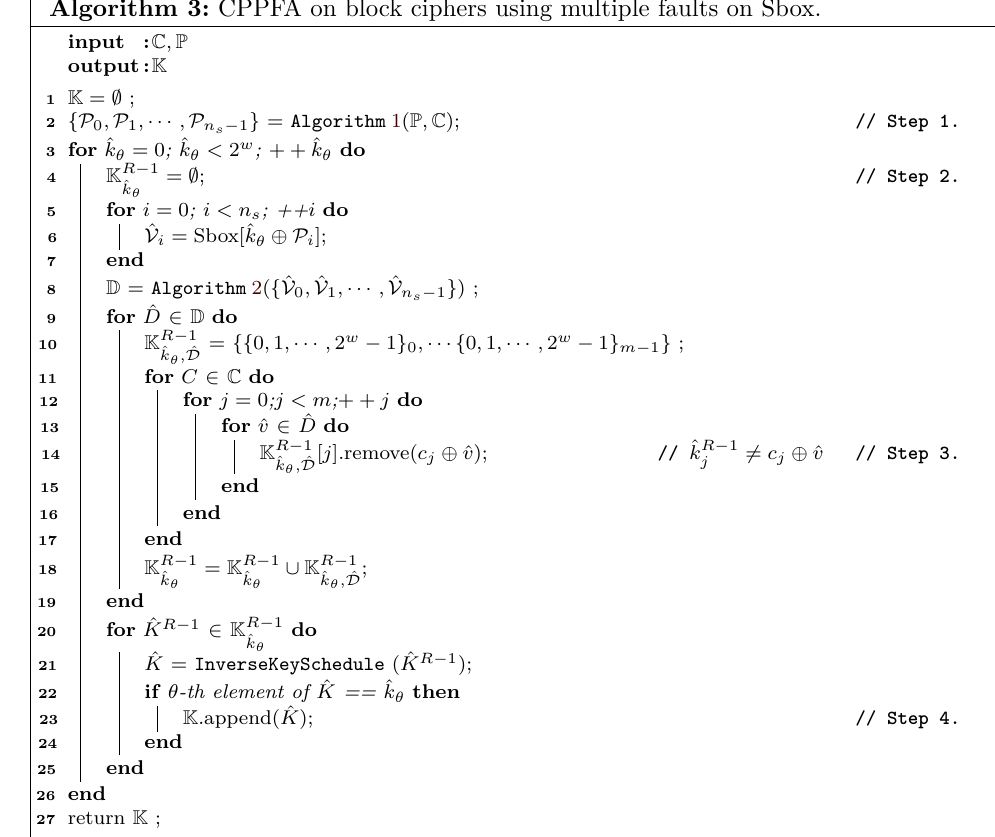
Algorithm 3: CPPFA on block ciphers using multiple faults on